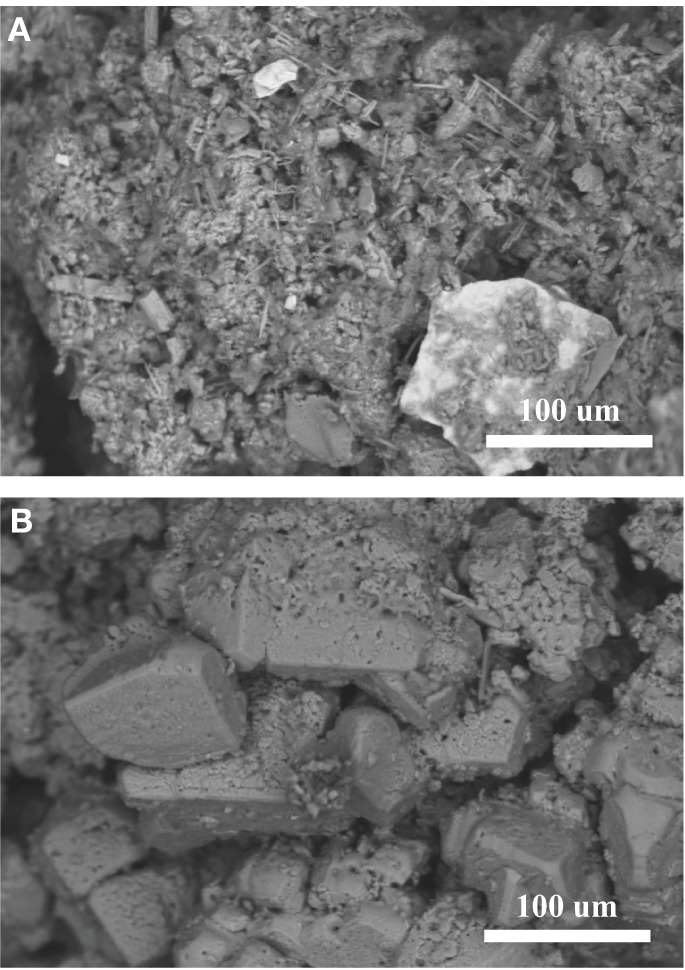
SEM of sediments collected from Manleluag. (A) Sediment from the bottom of a pool formed by a rimstone dam at CC1. Lithified pool bottoms show evidence of secondary precipitation in the form of aragonitic needles and bushes. (B) Rhombohedral crystals from the terrace rim.